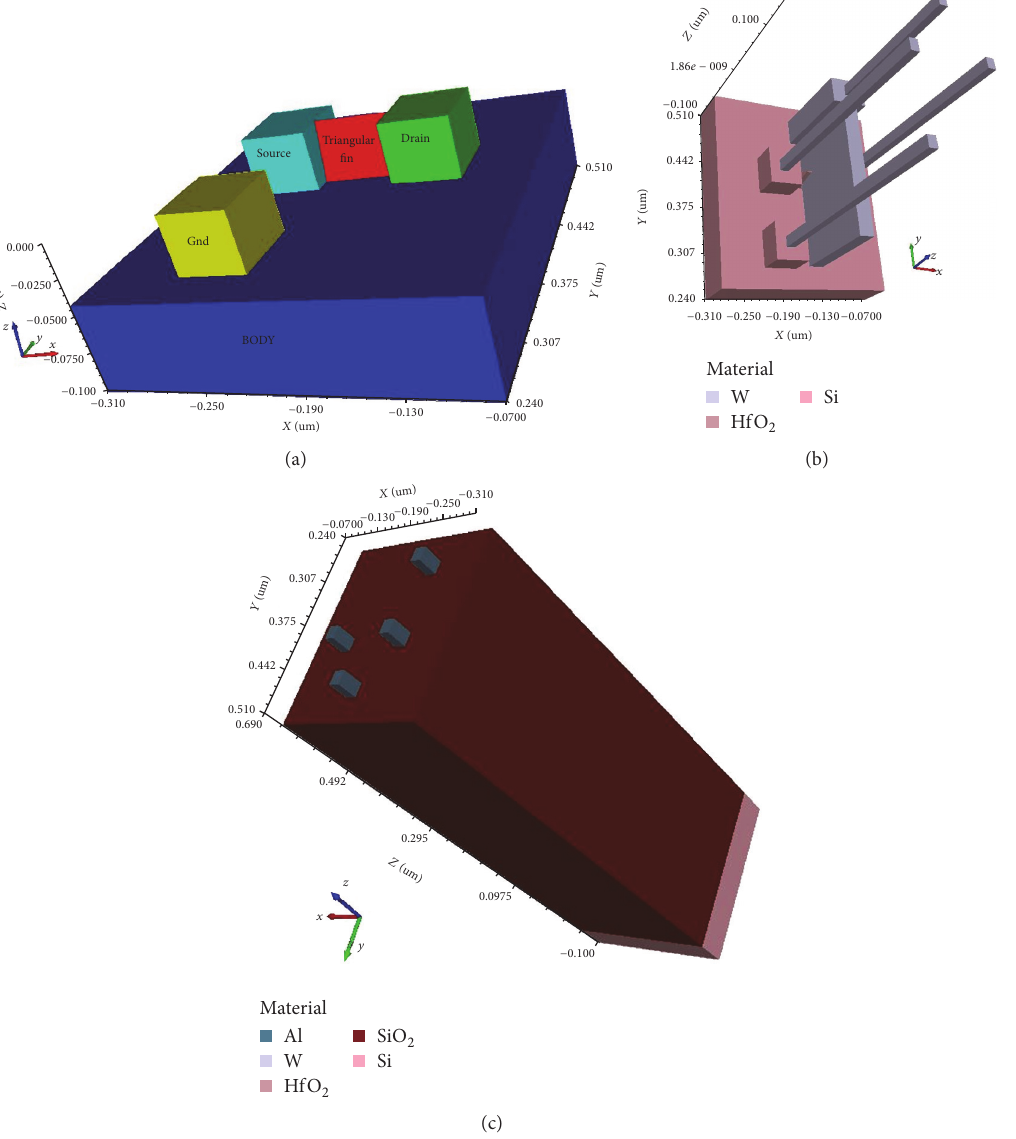
Figure 2: Bird’s eye view of 3D triangular FinFET device. (a) Active region with triangular fin. (b) Internal view with active region material. (c) Complete device 3D